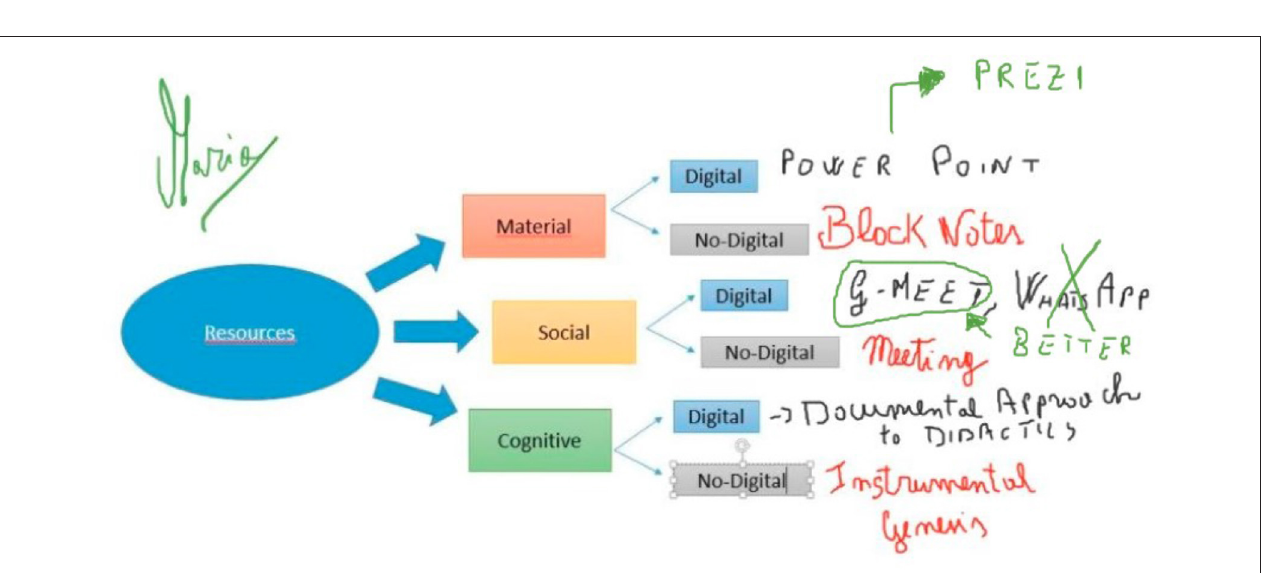
FIGURE 6 | The pilot teacher’s Reflective Mapping of Teacher Resource System in the second cycle.